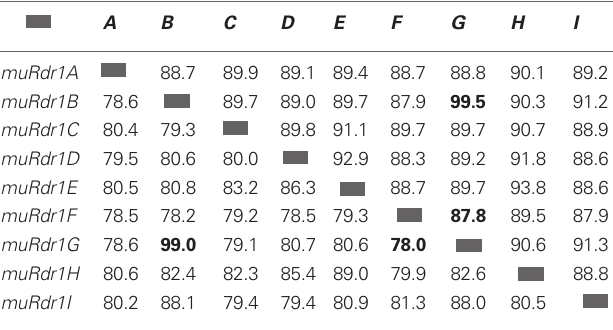
Table 2 | Nucleotide and amino acid sequence similarity of the nine muRdr1 –TNLs b .